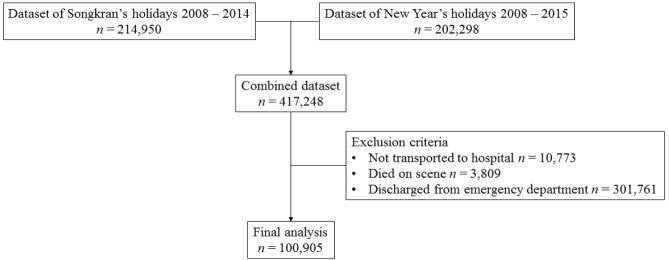
Flow chart of dataset for analysis of road traffic injuries in Thailand during Songkran’s and New Year’s holidays.